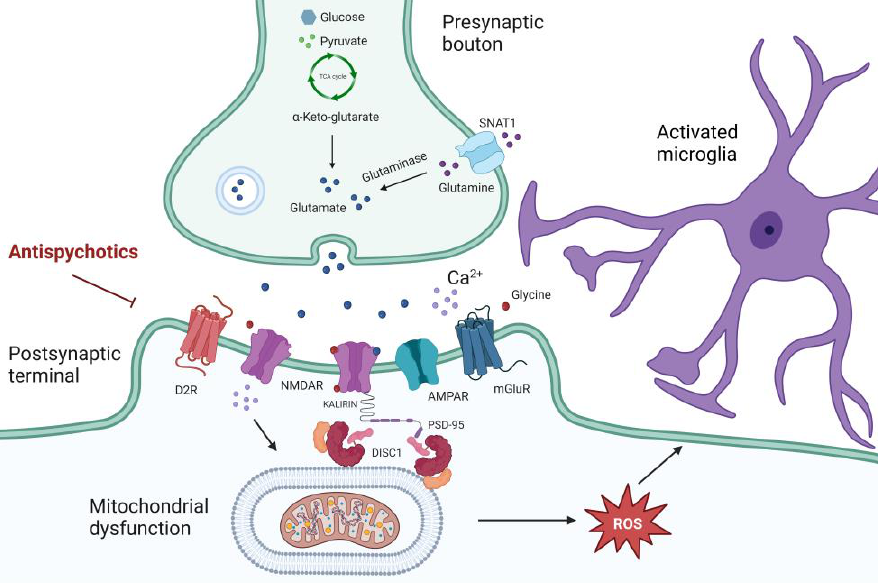
Figure 2. Mitochondrial dysfunction in schizophrenia can result in abnormal free radicals produc- tion and oxidative stress, which can be variously modulated by antipsychotic treatment. DISC1, a component of PSD with a putative role in mitochondrial fission and fusion, is also involved in schizophrenia pathophysiology. AMPAR = α -amino-3-hydroxy-5-methyl-4-isoxazolepropionic acid receptor; D2R = dopamine D2 receptor; Ca 2+ = calcium ion; DISC1 = disrupted-in-schizophrenia 1; mGluR = metabotropic glutamate receptor; NMDAR = N-Methyl-D-aspartic acid receptor; PSD-95 = postsynaptic density protein 95; SNAT1 = sodium-coupled neutral amino acid transporter 1. Created with BioRender.com; last accessed on 21 February